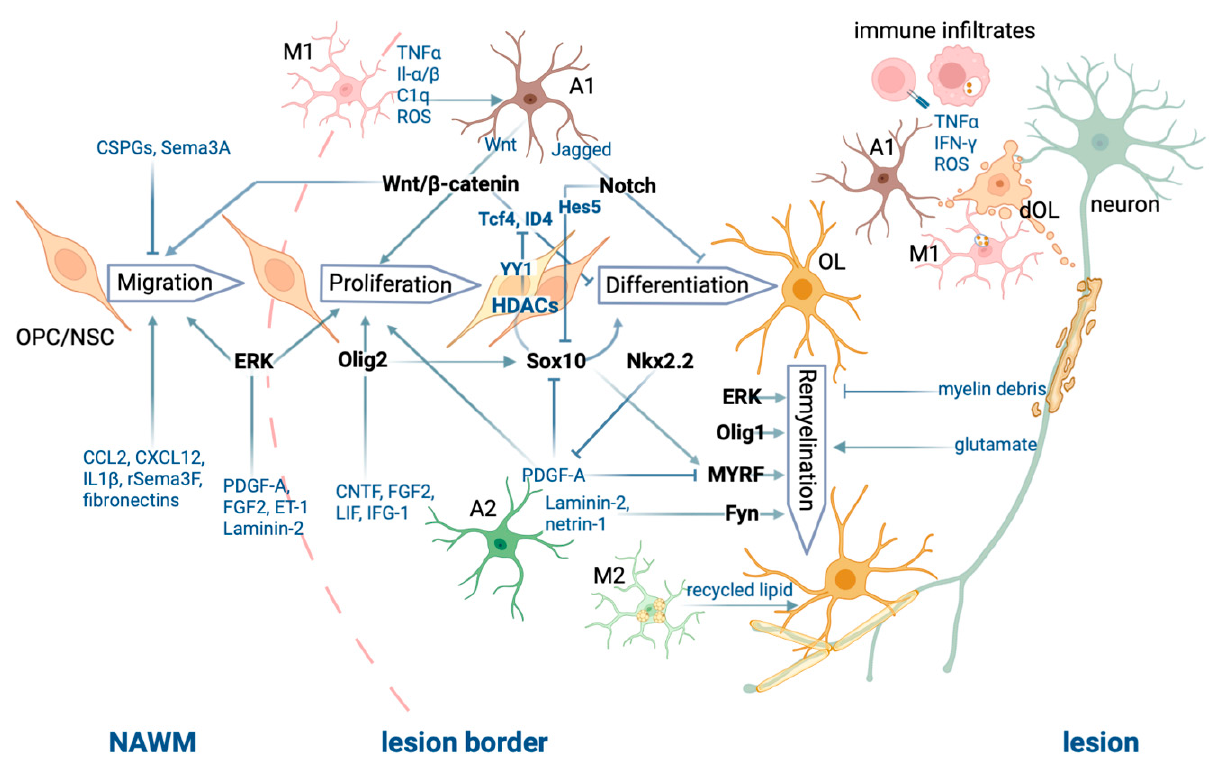
Figure 1. Summary of the processes of CNS demyelination and remyelination.